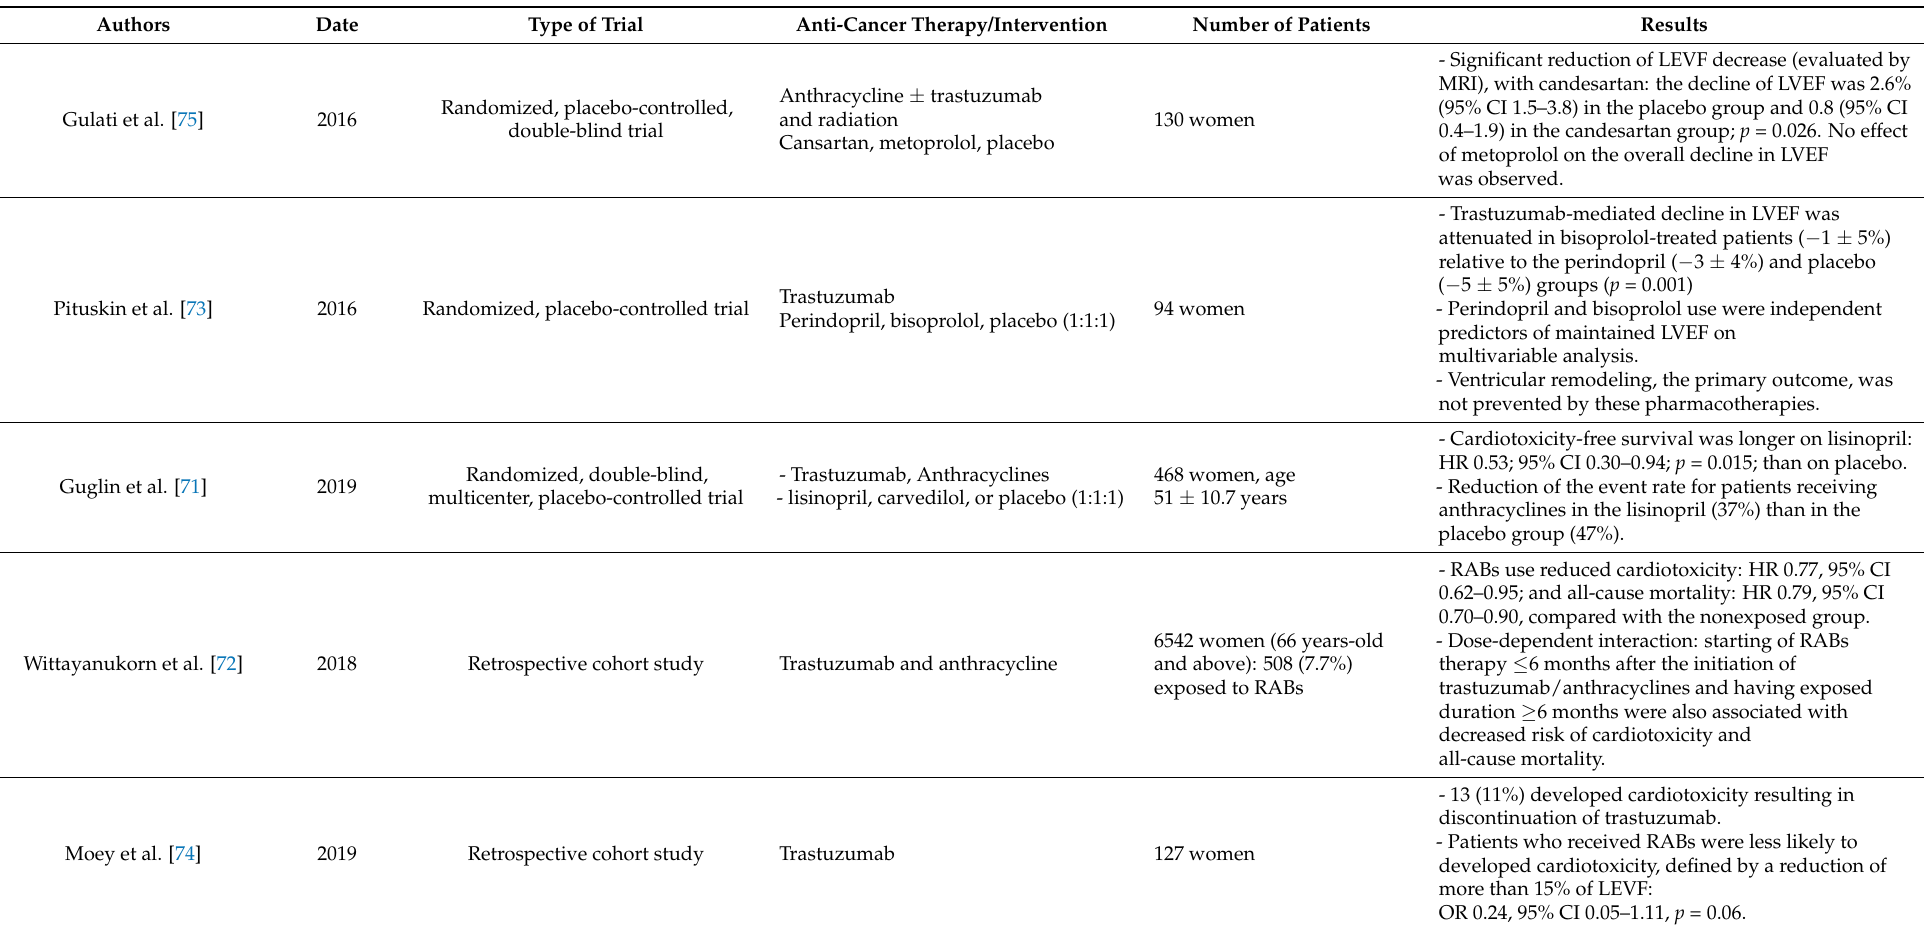
Table 4. Summary of studies about RAB use to prevent cardiotoxicity in breast cancer. Abbreviations: CI: confidence interval, HR: hazard ratio, LEVF: left ejection ventricular fraction, OR: odds ratio, RABs: renin-angiotensin-aldosterone system